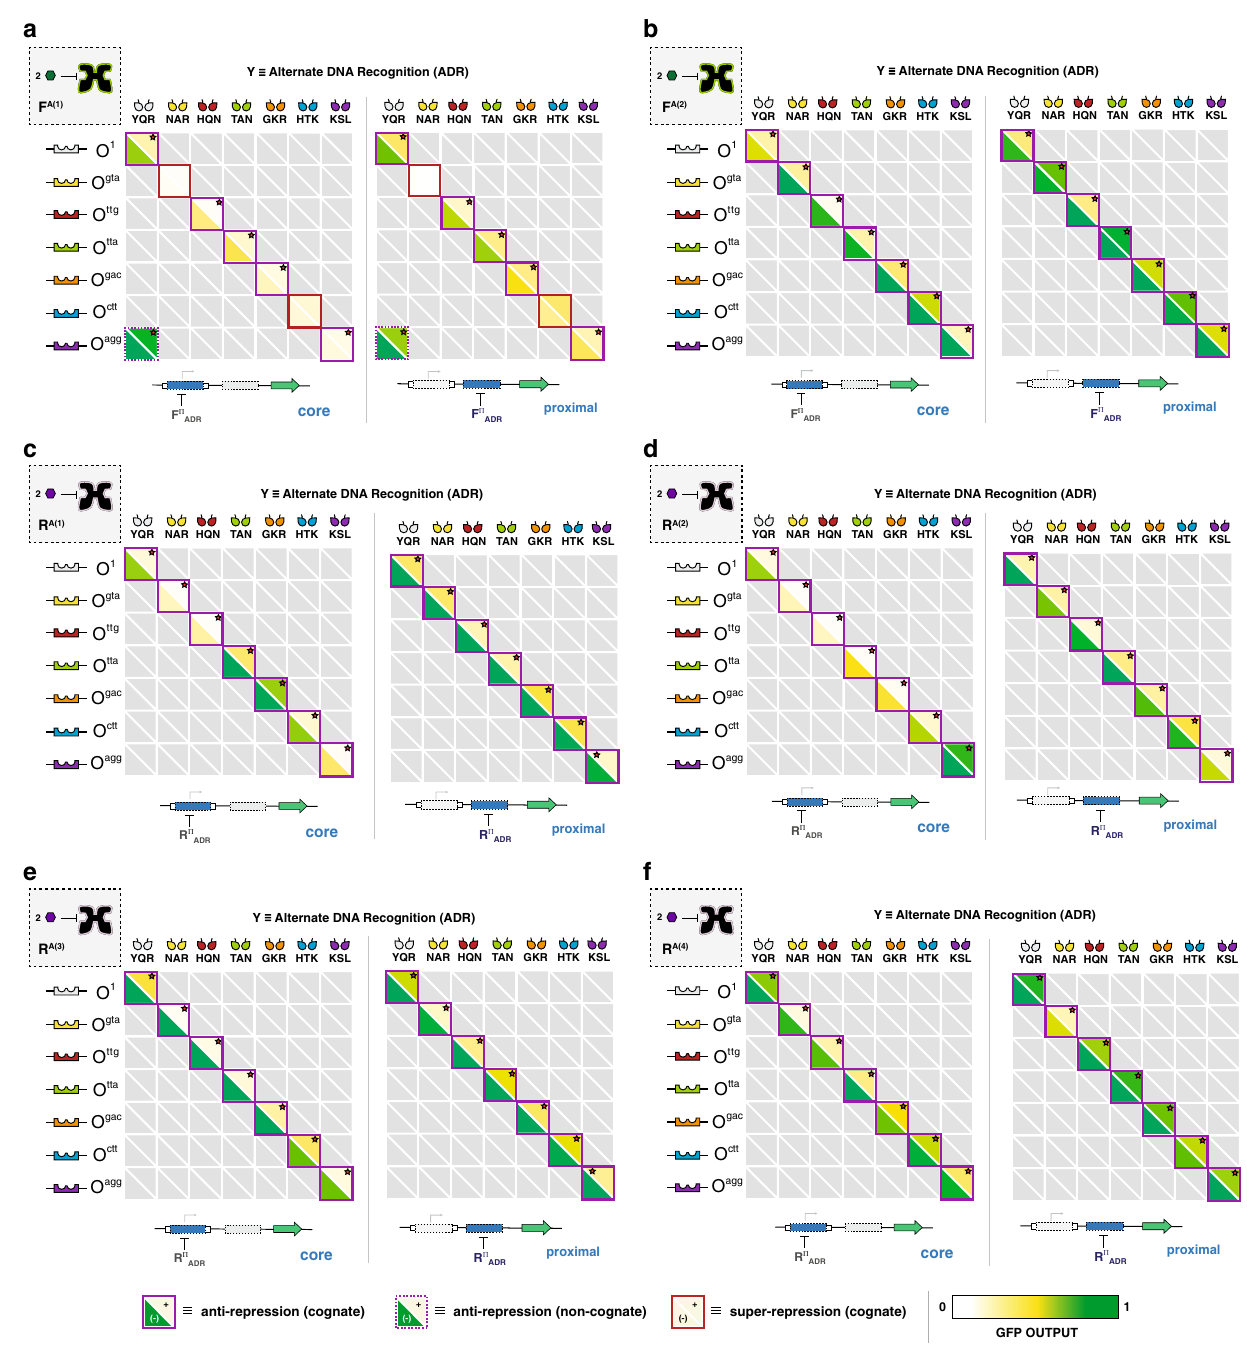
Fig. 4 Anti-repression matrices for engineered transcription factors. a anti-FruR (1) ; b anti-FruR (2) ; c anti-RbsR (1) ; d anti-RbsR (2) ; e anti-RbsR (3) ; and f anti-RbsR (4) . Each square represents an operator-DNA-binding domain pairing. DBDs are across the top of each matrix, with corresponding operators along the left side. The bottom-left sector of each square shows the mean fl uorescence intensity (OD 600 normalized, ex: 485 nm, em: 510 nm) in the absence of the inducer, whereas the top-right sector shows the normalized fl uorescence intensity in the presence of the inducer. Shaded colors of sectors correspond to the GFP output scalebar, shown at bottom. All values are standardized to the observed maximum output (measured with a LacI null control plasmid) for a given operator and operator position (core or proximal). Red stars denote a statistically-signi fi cant ( α = 0.001) difference in fl uorescence intensity between the two states using a Student ’ s two-tailed t -test. Solid outlines denote statistically-signi fi cant cognate interactions (along the matrix diagonal), whereas dashed outlines denote statistically-signi fi cant non-cognate interactions. Purple outlines denote anti-repressor (X A ) phenotypes and red outlines denote super-repressor (X S ) phenotypes. Values correspond to the mean of n = 6 biological replicates. Any DBD-operator pairing that did not show a super-repressor or anti-repressor phenotype (i.e., were nonfunctional, X − ) is shown grayed out. See Supplementary Fig. 7 for inverse anti- repression matrices. The left matrix in each set corresponds to testing with the operator in the core position and the right matrix corresponds to testing with the operator in the proximal